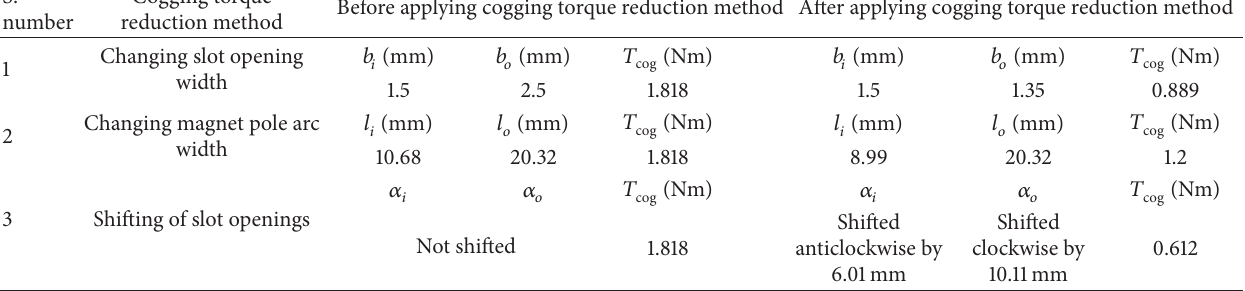
Table 2: Cogging torque values obtained before and after combined effect.